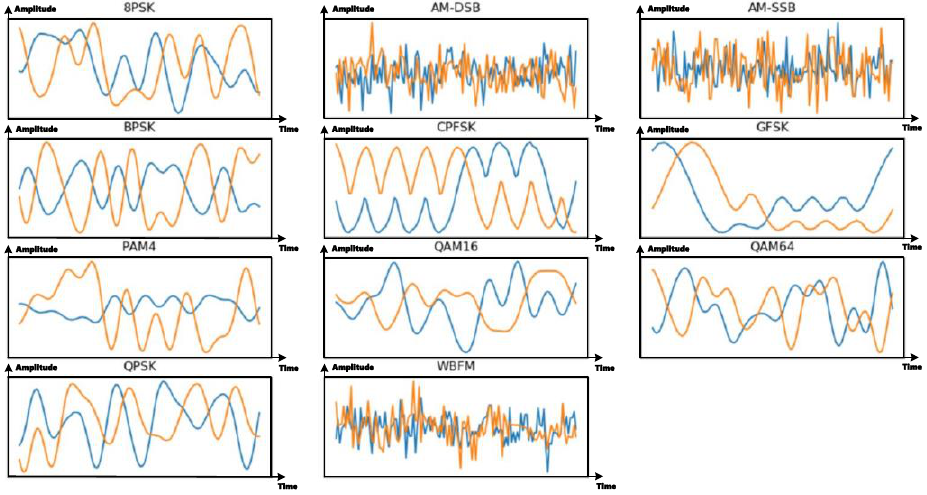
Figure 1. RML2016.10a data graph.